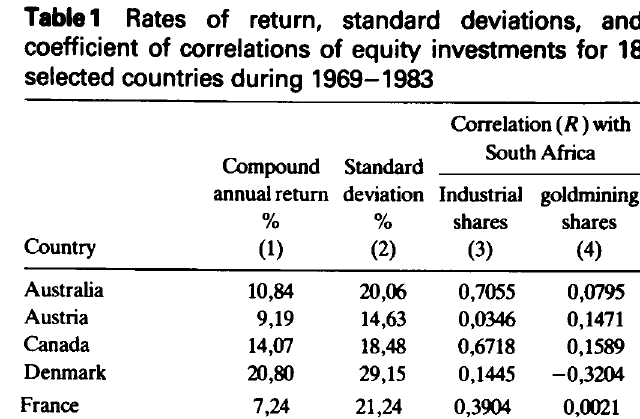
Rates of return, standard deviations, and coefficient of correlations of equity investments for 18 selected countries during